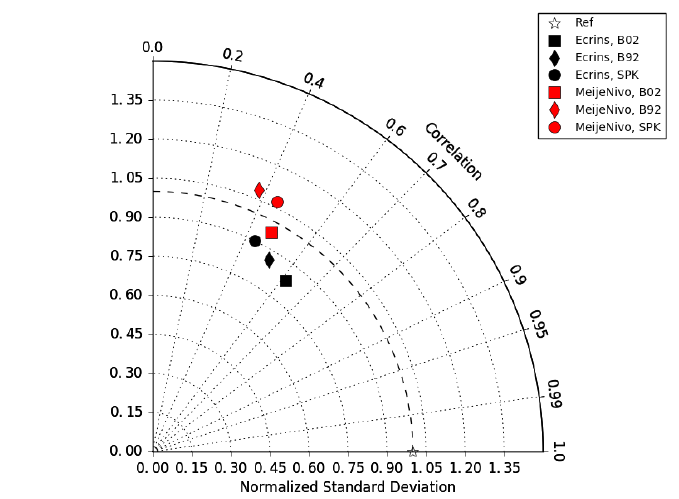
Figure 11. Taylor Diagram representing the normalized standard deviation and the correlation coefficient between the observations and the simulations for the two stations Meije-Nivose at 3100 m and Les Ecrins at 2978 m and for the three schemes of the percolation of the liquid water in the